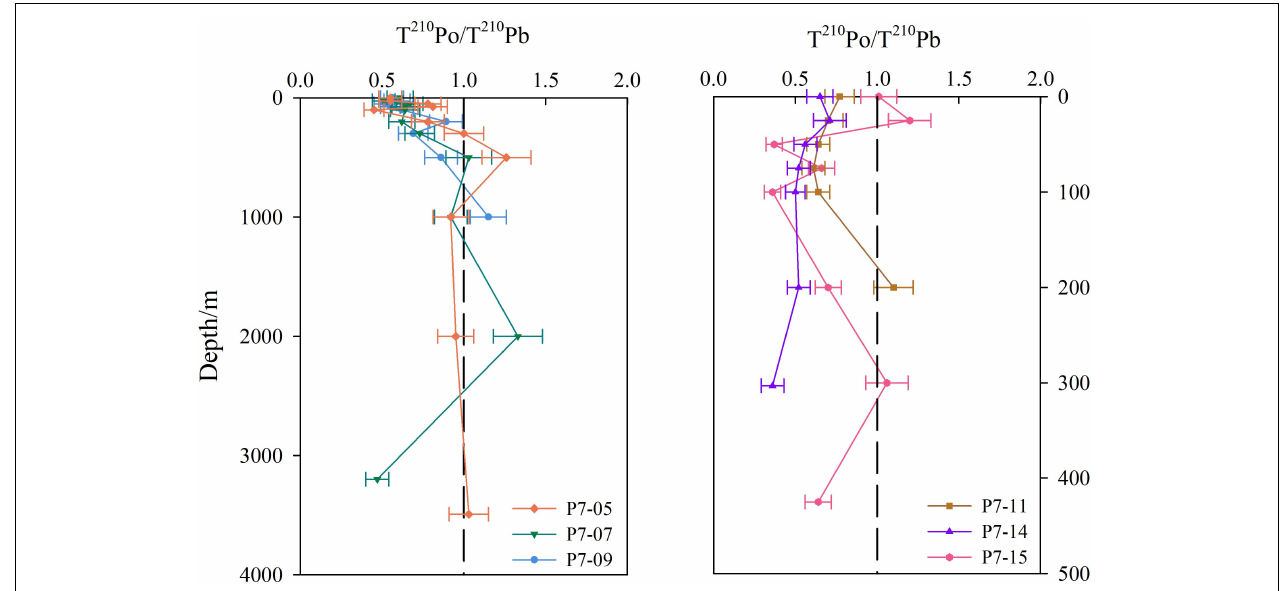
FIGURE 4 | Profiles of T 210 Po/T 210 Pb activity ratio at sites around Prydz Bay. The left panel is stations in the slope and the basin, and the right panel is stations in the shelf.